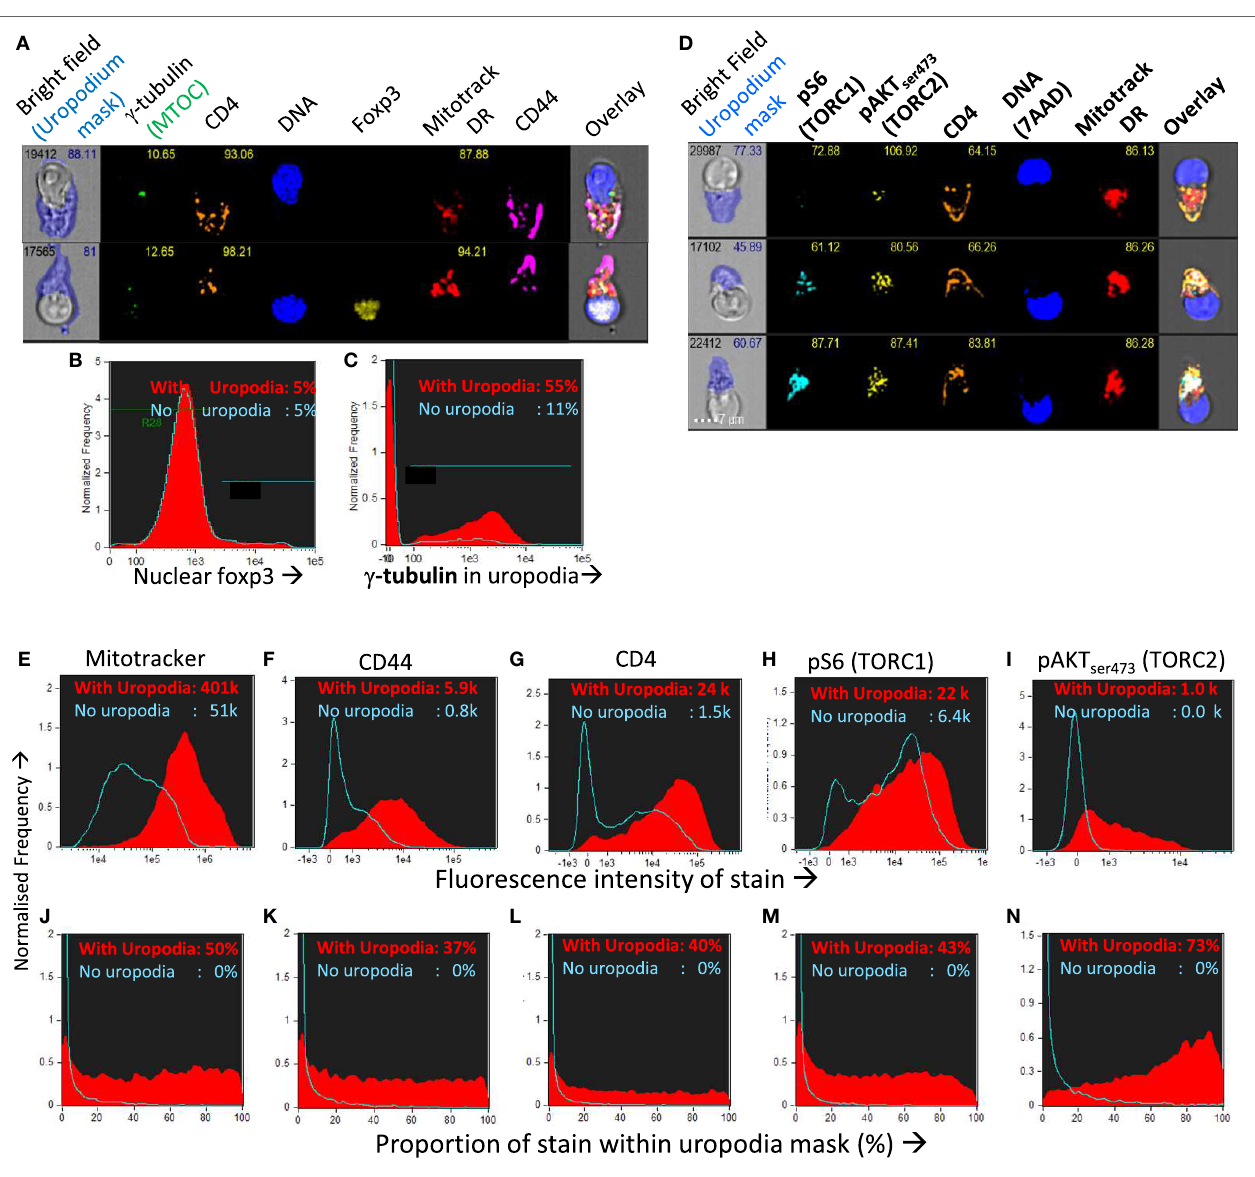
FigUre 8 | Confirming that the image masking strategy used is correctly identifying uropodia containing high numbers of mitochondria, high CD4 and CD44 expression, and mTOR signaling. (a–c) CTV-labeled naïve female A1RAG CD4 + T cells were stimulated with bone marrow-derived dendritic cells (bmDC) + 100 nM Dby peptide with IL2, TGF β , and ATRA for 3 days. Cells were labeled “ in situ ” with CD4-PE-CF594, CD44-APC-Cy7, Mitotracker DR, and live/dead aqua, fixed and permeabilized, and intracellularly stained for γ -tubulinAlexaFluor488, and foxp3-PE-Cy7. Example images are shown in (a) . The distribution of nuclear foxp3 staining was identical comparing cells with or without uropodia (b) and γ -tubulin staining, indicating the microtubule organizing center (MTOC) was strongly associated with uropodia (c) . (D–n) CTV labeled naïve A1RAG CD4 + T cells were stimulated with bmDC + 100 nM peptide under optimized conditions (see Materials and Methods) for 3 days and then “ in situ ” labeled with CD4-PE-CF594, CD44-APC-eflour780, CD62L-BV605 (not shown), live/dead aqua and Mitotracker DR, fixed and permeabilized, then stained with pS6-Alexa488, pAKTS473-PE, Foxp3-PE-Cy7 (not shown), and 7AAD for ImageStream analysis. All images were gated for live, singlet cells in G 0 /G 1 as previously. Example images, with uropodia masks indicated, are shown in (l) , and cells with a uropodium area greater or lesser than 10 µm 2 were defined as positive (red filled histograms) or negative (blue histograms), respectively. (e–i) Show the intensity histograms for each stain of interest, while (J–n) show the proportions of each stain that fall within the uropodium gate for each image. Median values for each plot are indicated. Shown are representative examples of three or more independent